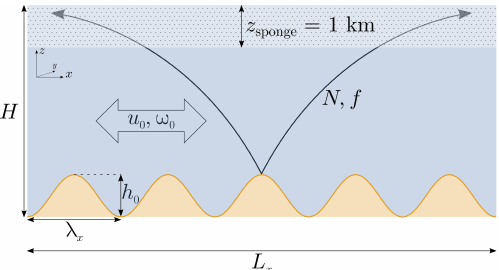
Figure 1. A diagram of the numerical experiment setup. The schematic shows interactions of the barotropic tide with bottom topography that generates internal waves represented by rays traveling away from topographic peaks. Table 1. Model domain specifications for the 2-D simulations.